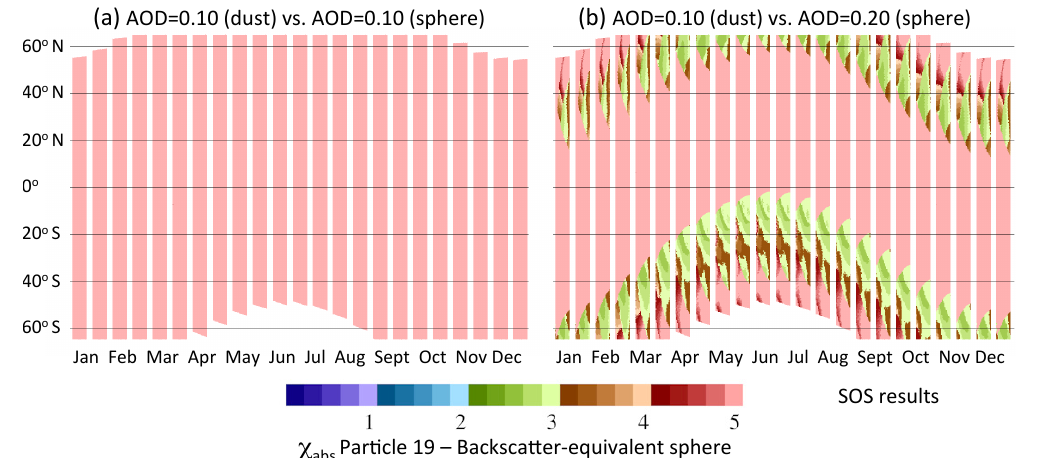
Fig. 16. χ 2 calculated for MISR red and NIR wavelengths only for a Rayleigh-scattering atmosphere containing only MISR Particle 19 abs over a black surface and a Rayleigh-scattering atmosphere containing only the backscatter-equivalent spherical particle, as in Fig. 13, but considering full multiple scattering based on SOS radiative transfer calculations. (a) AOD=0.1 for both aerosol models, (b) AOD=0.1 for Particle 19, and AOD=0.2 for the backscatter-equivalent sphere.